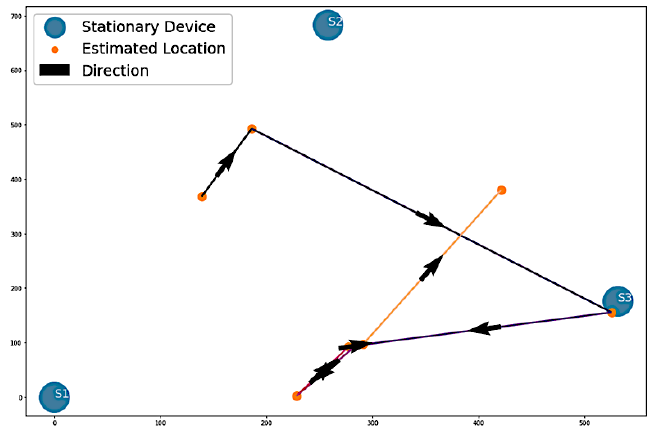
Figure 12. Algorithm 1’s estimation of Path 2.